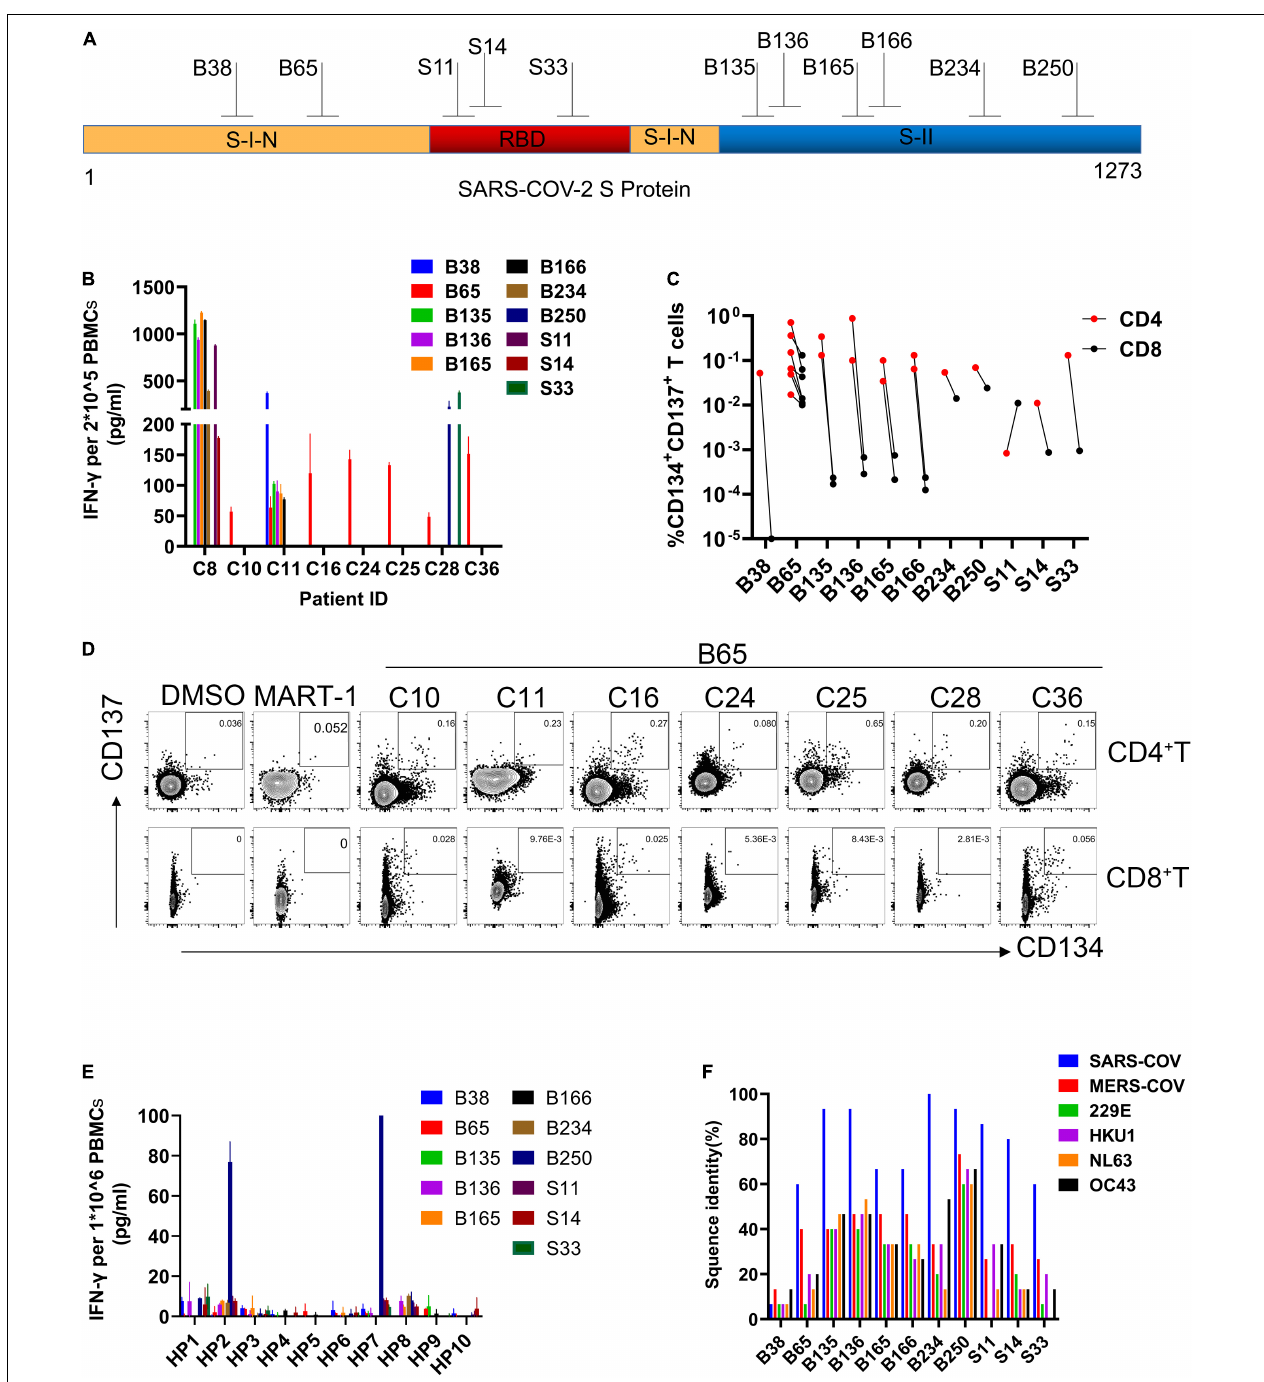
FIGURE 3 | Identification of SARS-CoV-2 S protein-specific CD4 + and CD8 + T cell epitopes. (A) The structure of SARS-COV-2 spike glycoprotein. (B) IFN- γ was determined by ELISA. 2 × 10 − 5 PBMCs for each participant were stimulated with a single peptide from positive mix pools (24 h). (C) The frequency of reactive CD4 + and CD8 + T cells to each peptide in participants. (D) FC plot example. FC was used to detect the reactive CD4 + T cells (CD3 + CD4 + CD8-CD134 + CD137 +) or CD8 + T cells (CD3 + CD4-CD8 + CD137 + CD134 +) in PBMCs stimulated by positive peptide or MART-1 (negative control) (48 h). (E) IFN- γ ELISA assays were used to evaluate the cross-reactivity of HP to peptide. 1 × 10 − 6 PBMCs for each HP were stimulated with each peptide (24 h). (F) The proportion of sequence identity of SARS-CoV-2 spike glycoprotein to the spike glycoproteins of SARS-COV, MERS-COV, and human common cold coronaviruses 229E, HKU1, NL63, and OC43. IFN- γ , interferon- γ ; ELISA, enzyme-linked immunosorbent assay; PBMCs, peripheral blood mononuclear cells; FC, flow cytometry; SARS-CoV-2, severe acute respiratory syndrome coronavirus 2; SARS-COV, severe acute respiratory syndrome coronavirus; MERS-COV, Middle East respiratory syndrome coronavirus (MERS-CoV); MART-1, melanoma-associated antigen.